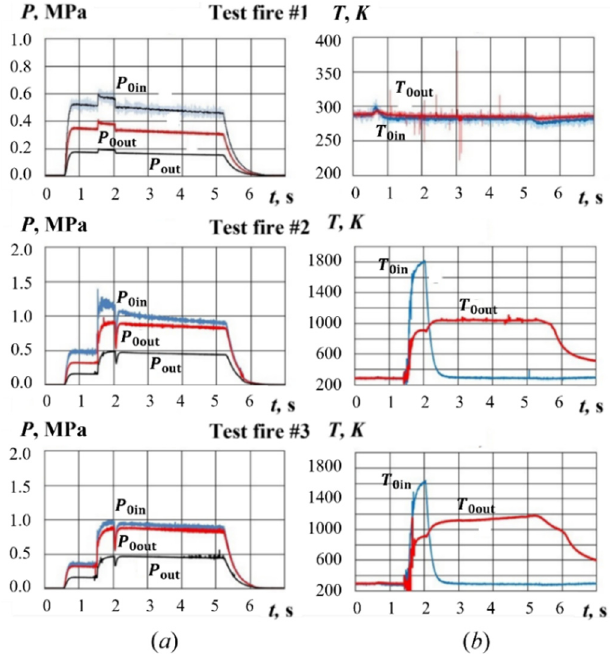
Figure 9. Time histories of ( a ) pressure and ( b ) temperature at PP sample inlet and outlet in test fires #1 to #3.